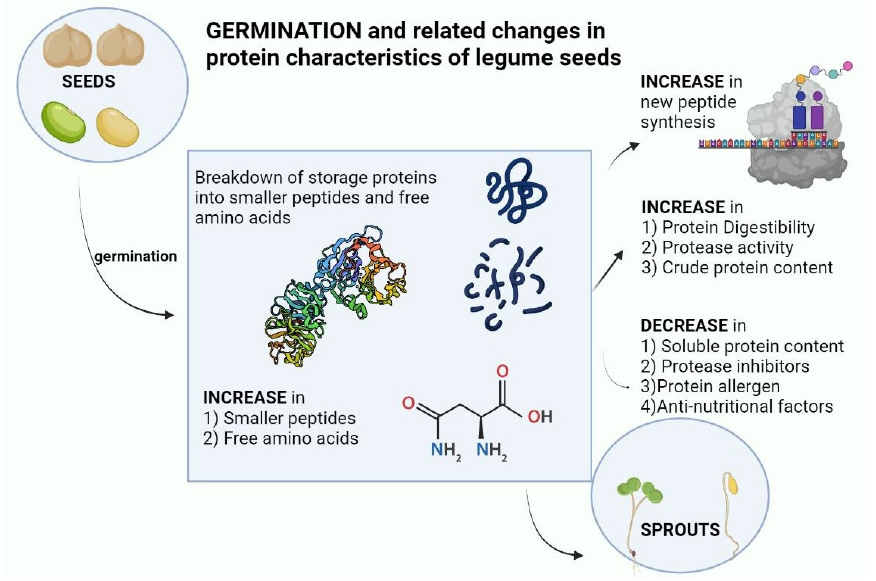
Figure 4. Changes in protein characteristics of legume seeds on germination (created with BioRen- der.com URL (accessed on 18 January 2023).